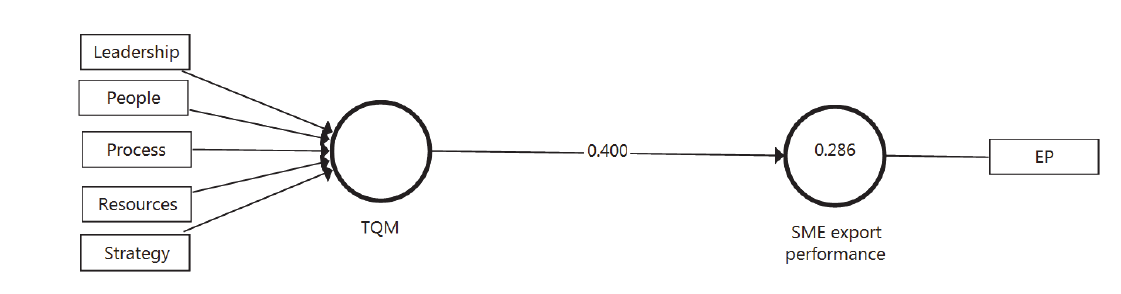
Fig. 4. Values of R2 and f2